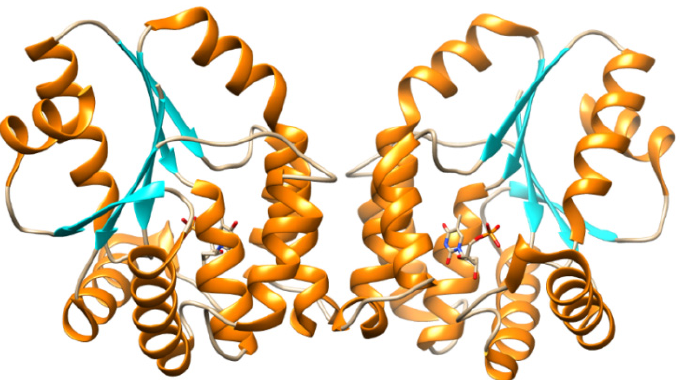
Figure 13. Structure of TMPK mtb –TMP complex (protein is presented in the form of a ribbon [82]. https://www.rcsb.org/structure/1N5I, (accessed on 17 January 2022).